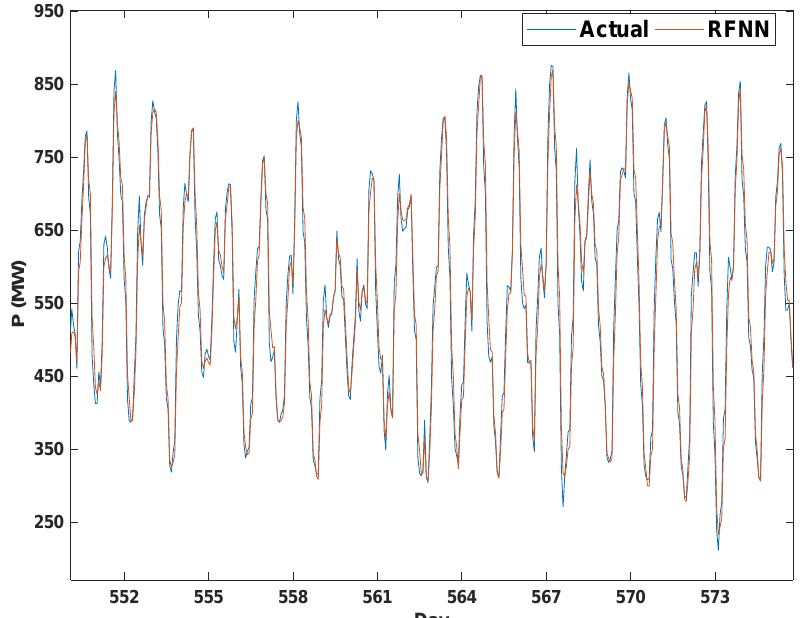
Figure 5. Zoom in Figure 4. (Days 552 to 573).